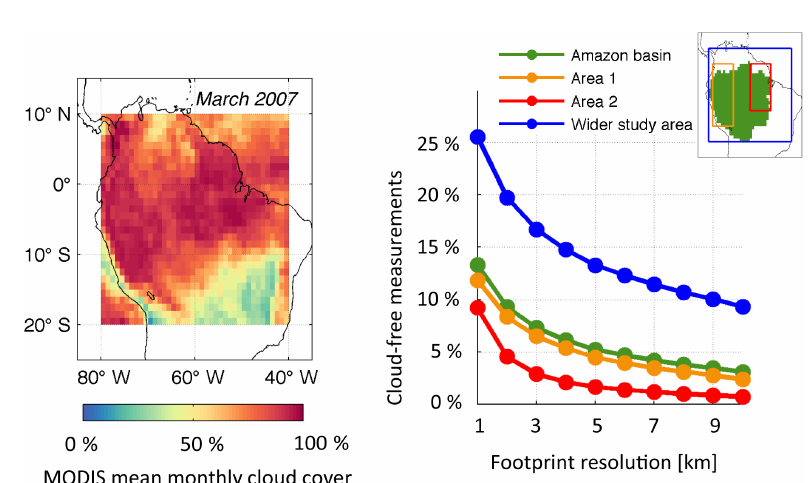
Figure B1. Left: March 2007 mean MODIS cloud cover aggregated to 1 ◦ × 1 ◦ . Right: summary of March 2007 cloud-free observations vs. footprint size for the broader study area, the Amazon River basin and two subregions (eastern and western Amazon River